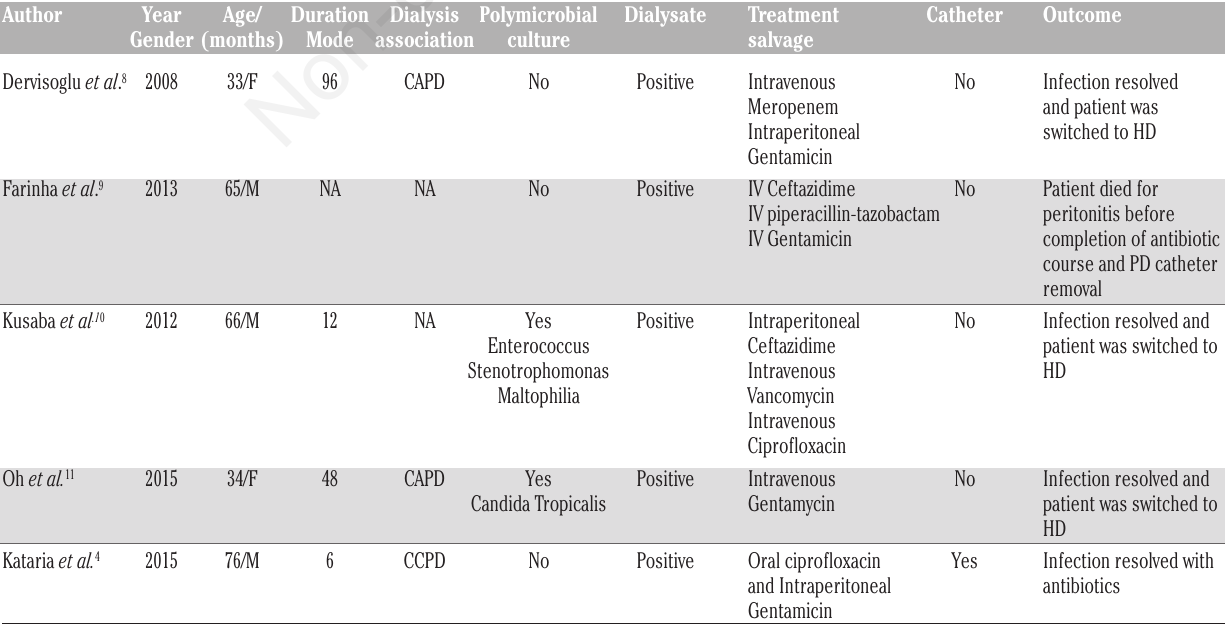
Table 3. Summary all the cases listed as Citrobacter freundii peritonitis with patients on dialysis as per PubMed review of